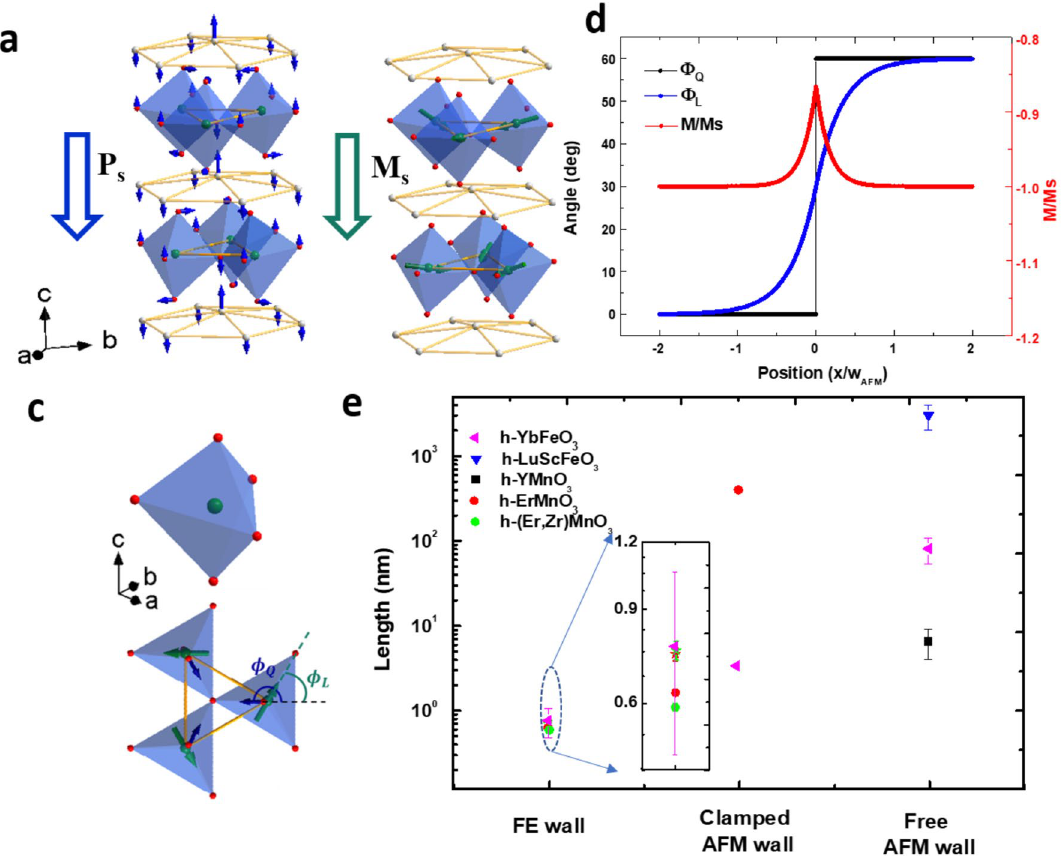
Figure 1. ( a ) Atomic structure and K 3 structural distortion of h- R FeO 3 . Green, white, and red spheres represent Fe, rare-earth, and O atoms, respectively. The arrows indicate the displacement of the O and the Yb atoms of the K 3 mode. ( b ) Schematic illustration of weak ferromagnetism (or canted antiferromagnetism) of h- R FeO 3 , the green arrows through the Fe atoms represent the spin directions. ( c ) FeO 5 bipyramids and the definition of order parameters φ Q and φ L . ( d ) Schematic profiles of φ Q , φ L and normalized magnetization at the clamped AFM wall in h-YbFeO 3 , based on numerical simulation (see text). ( e ) Comparison of characteristic widths of FE wall, clamped and free AFM walls in multiferroic hexagonal ferrites and manganites, the inset is the close-up view of the data of the FE walls. Data for h-(Lu,Sc)FeO 3 , YMnO 3 , h-ErMnO 3 and h-(Er,Zr)MnO 3 comes from Ref. 11, 23, 28, 31, respectively. The width of the clamped AFM wall of h-YbFeO 3 is from the simulation in ( d ). The width of free AFM wall of h-YbFeO 3 is from the fitting of frequency shift of MFM image (see Fig.